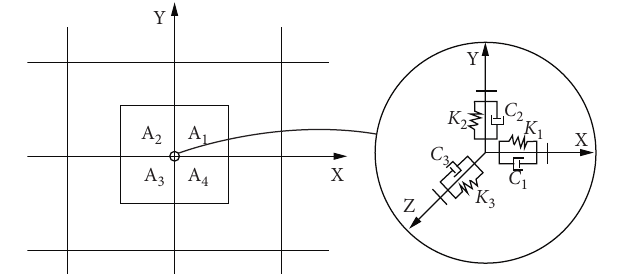
Figure 12: Artificial boundary.